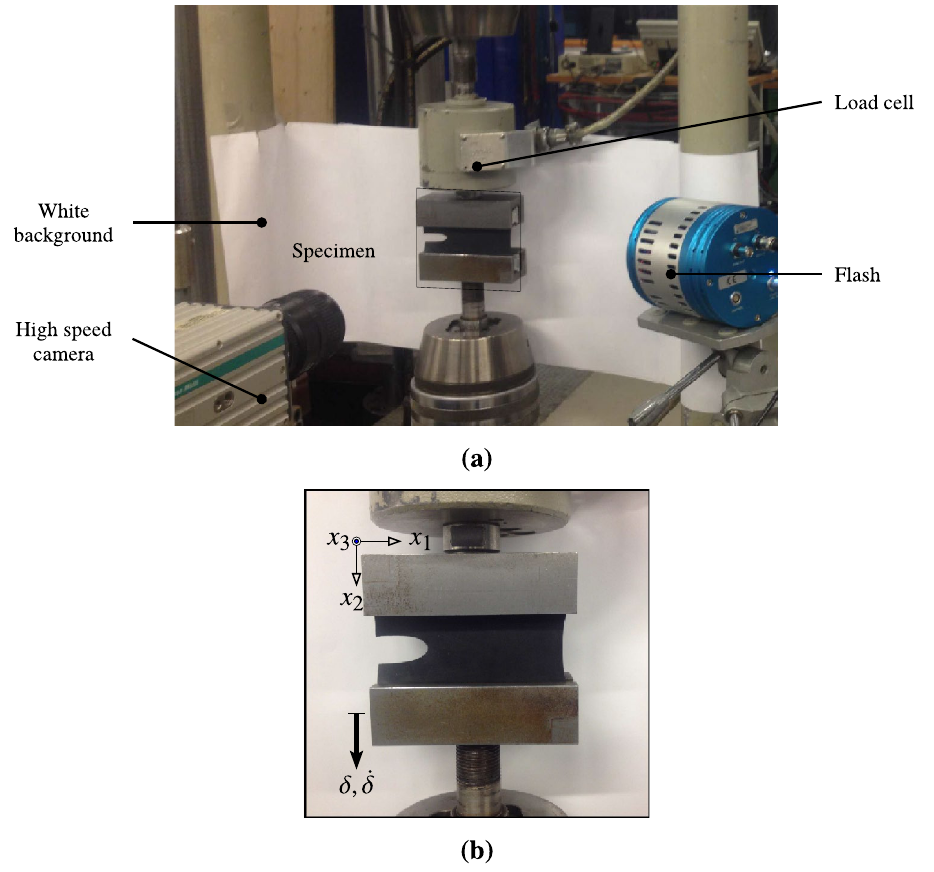
Figure 5. The experimental setup: (a) the loading machine, the cracked pure shear specimen and the high speed camera; (b) the cracked pure shear specimen, the loading direction and the experiment